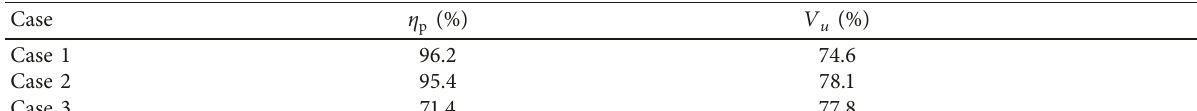
Table 5: Evaluation index of inlet passage.